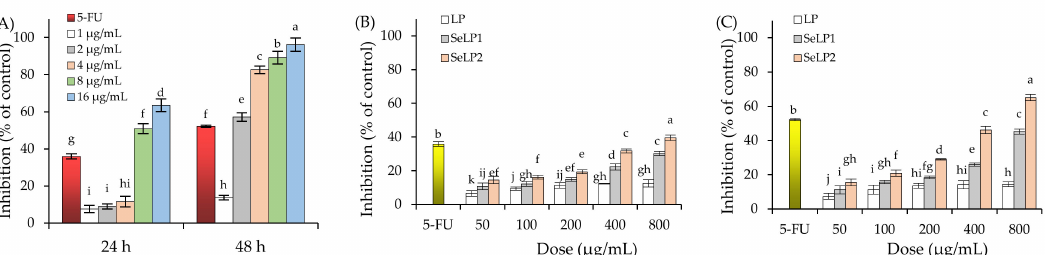
Figure 1. Growth inhibition of 5-Fu (100 µ mol/L) and Na 2 SeO 3 ( A ) as well as longan polysaccharides (LP) and two selenylated polysaccharides (SeLP1 and SeLP2) on HT-29 cells with exposure times of 24 ( B ) and 48 h ( C ). Different lowercase letters above the columns indicate significant differences ( p <